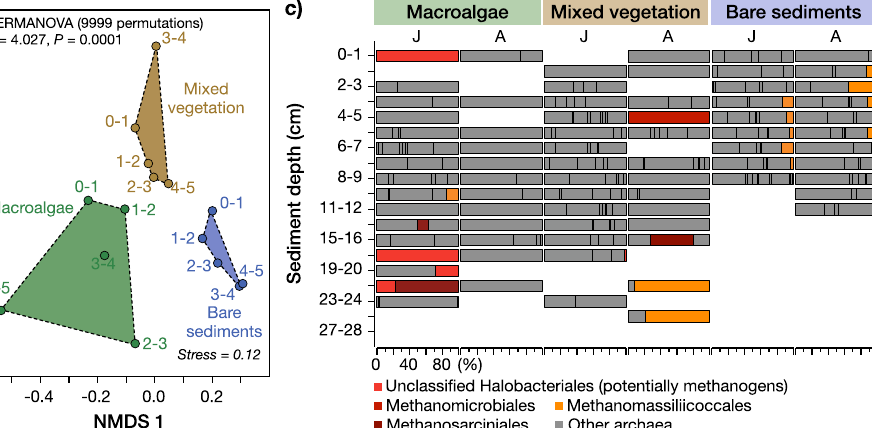
known methanogenic archaeal community (according to the SILVA v138.1 database) onthelowesttaxonomicclassi fi edlevelduringthesamplinginJuly(J)andAugust(A). The y-axis shows the different sediment layers, while the x-axes show the relative abundance(%ofallarchaea,labelsonlyshownon fi rstx-axis). “ Otherarchaea ” denote groups <0.1% average of all samples. Taxonomic labels in color denote known methanogensinthedatasetaccordingtoscienti fi cliterature.Notethatforthestation “ bare sediments ” , samples could only be collected down to 9cm (July) and 12cm (August). Empty cells denote that no archaea were detected in the